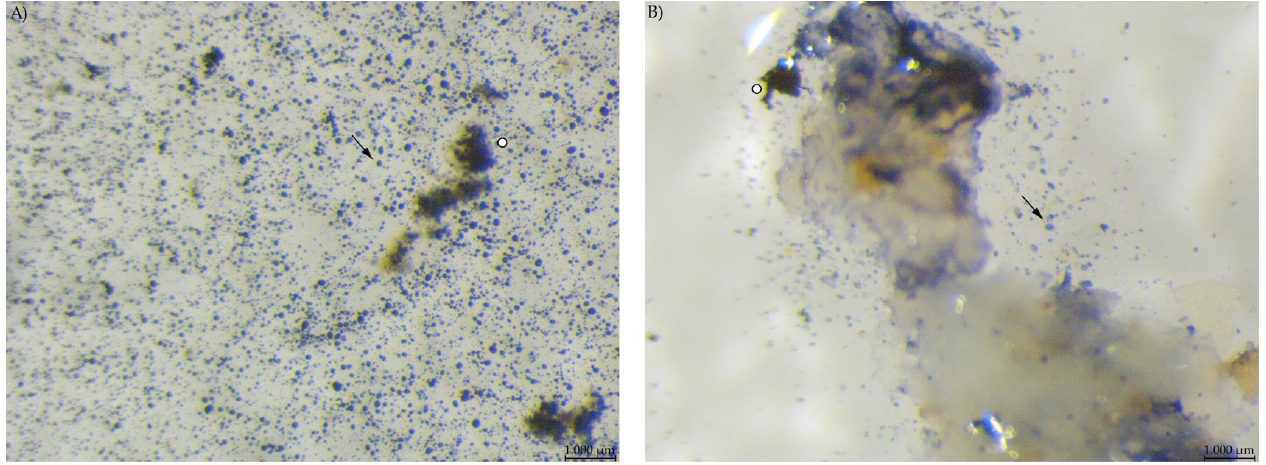
Figure 4. Diet samples stained with Lugol ’ s iodine. ( A ) PEL with a high number of small, round stained starch particles; ( B ) EXT with less compact stained particles, larger fragments and starch in the soluble fraction (stereomicroscopy, 40 ×; ○ marking larger fragments of starch, ↓ marking small round particles).